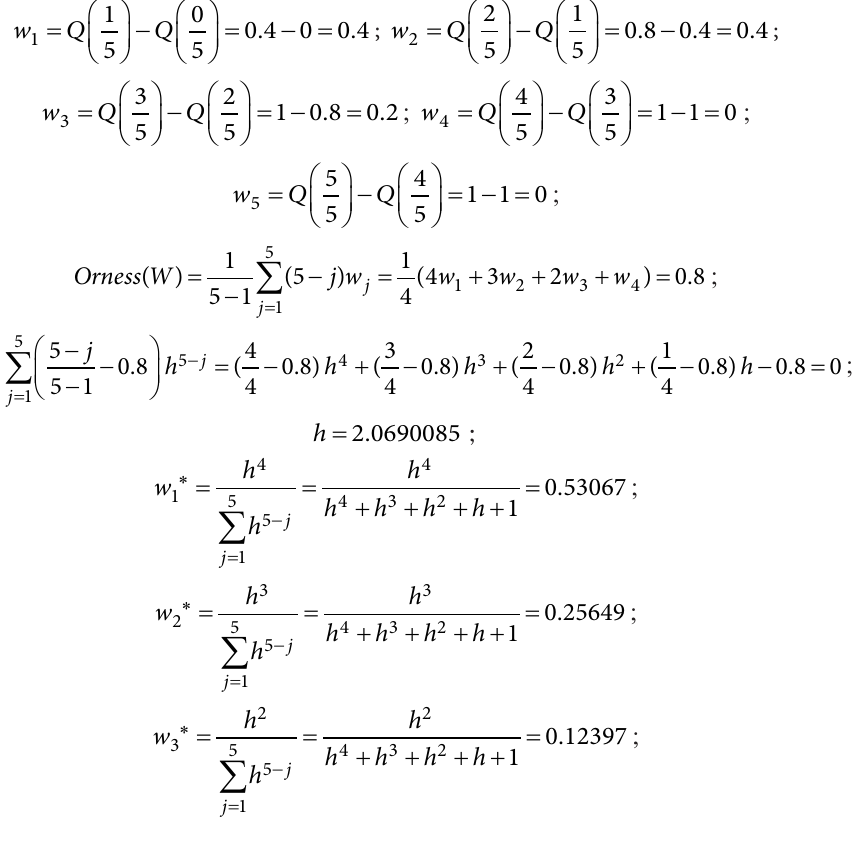
Artistic modeling Must-be quality